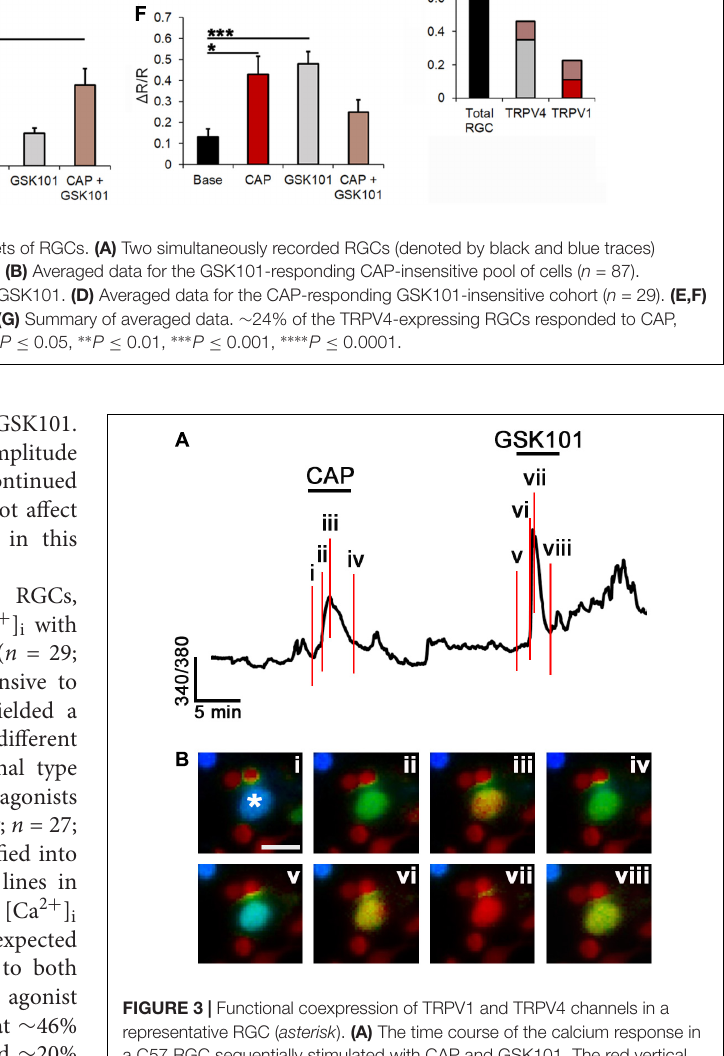
FIGURE 3 | Functional coexpression of TRPV1 and TRPV4 channels in a representative RGC ( asterisk ). (A) The time course of the calcium response in a C57 RGC sequentially stimulated with CAP and GSK101. The red vertical lines denote the time points shown in panel Bi–viii . (B) Ratio images from the RGC (asterisk) shown in A . Note that [Ca 2 + ] i declines in the continued presence of both agonists. The small-diameter somata adjacent to the RGC are rod somata. Scale bar = 10 µ